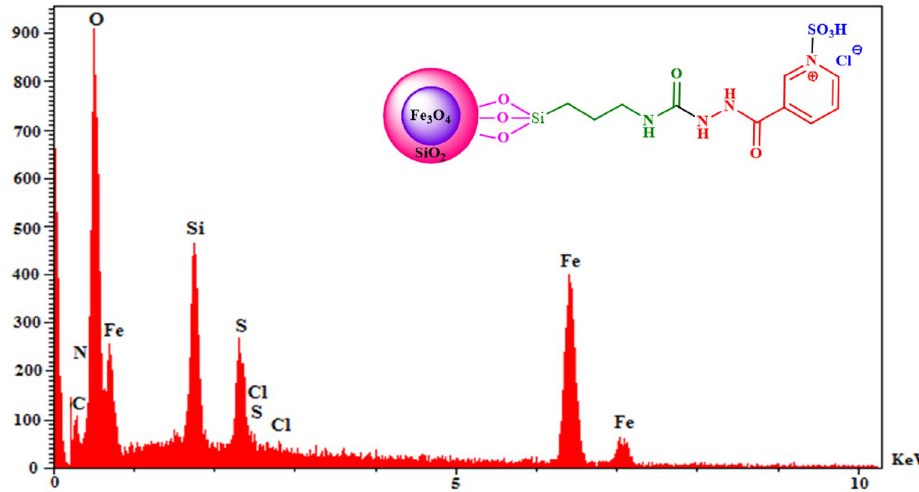
Figure 5. The EDX analysis of the FSiPSS nano-catalyst.